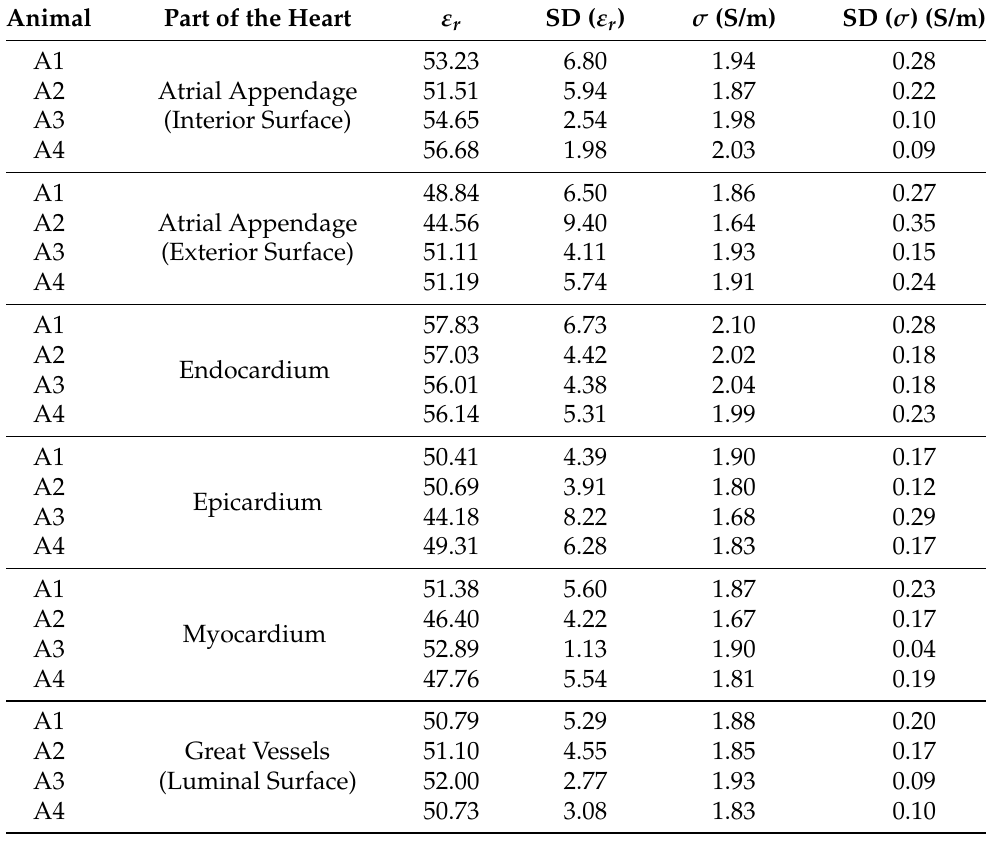
Table 2. The values of the relative permittivity and conductivity of the measured parts of the heart at 2.4 GHz. The values given as the mean and standard deviation (SD) across all measurements on a particular part of the heart. These part of the heart specific values can be used in single frequency numerical